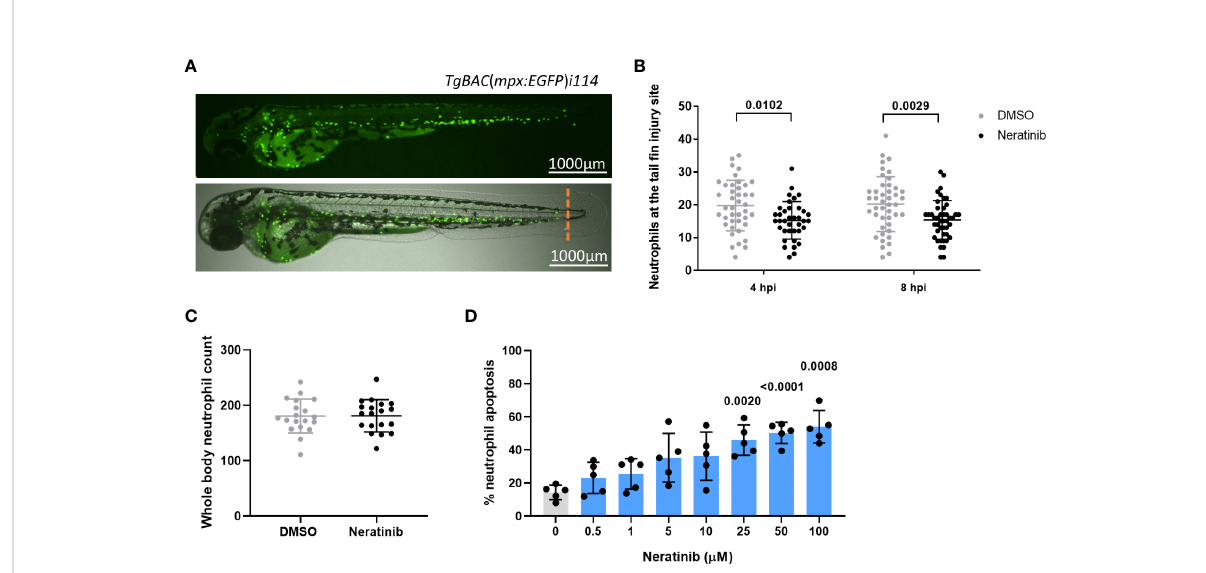
FIGURE 1 Neratinib reduces neutrophilic in fl ammation at the tail fi n injury site of zebra fi sh larvae in vivo and induces apoptosis of human neutrophils in vitro . Neutrophils in zebra fi sh larvae can be enumerated by fl uorescence microscopy using the transgenic line TgBAC ( mpx:EGFP ) i114 , in which each GFP-expressing (green) cell is counted as one neutrophil (A) . Tail fi n transection (A, orange dotted line) was performed after 16 h of treatment with neratinib, and neutrophils at the site of injury enumerated 4 and 8 h post-injury. Larvae treated with neratinib had reduced numbers of neutrophils at the tail fi n injury site at both time points in comparison to DMSO-treated larvae (B) . Minimum n = 30 larvae per condition across three experimental repeats; data analyzed by two-way ANOVA with Sidak ’ s multiple comparisons. Total neutrophil